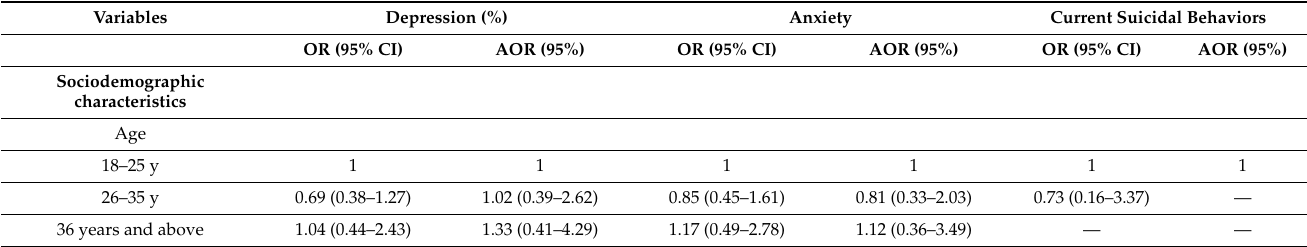
Table 2. Multivariate analyses of demographic, psycho-behavioral and socio-environmental predictors of depression, anxiety and